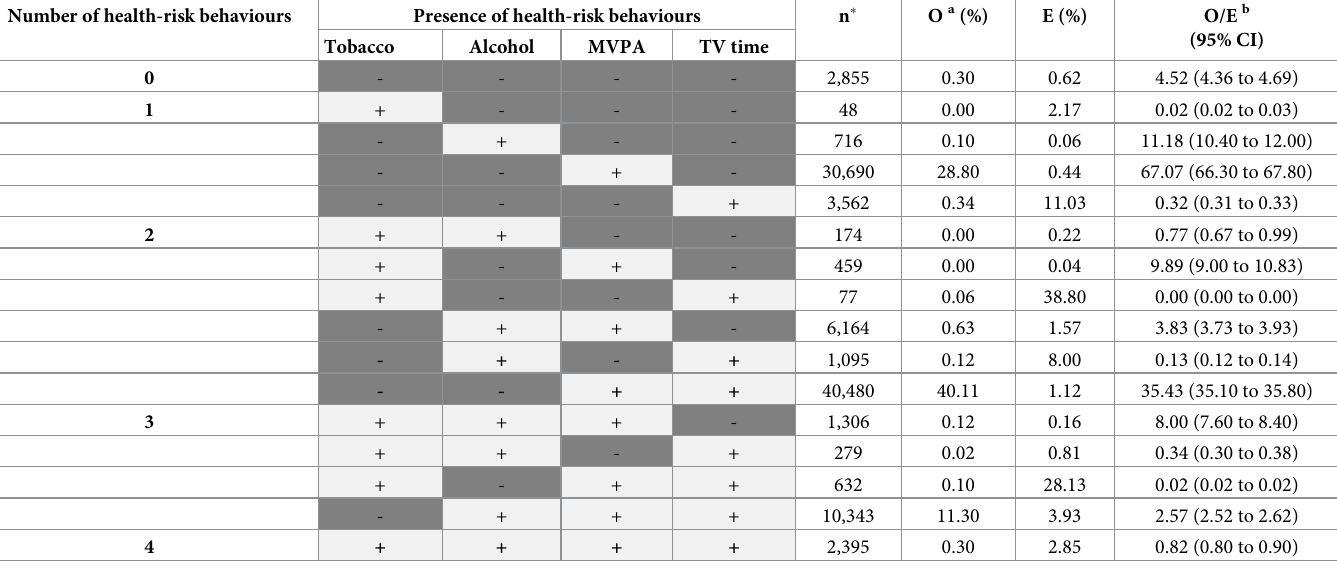
Table 2. Simultaneity of health-risk behaviours in Brazilian students. National Adolescent School-based Health Survey (PeNSE). Brazil, 2015 (n =